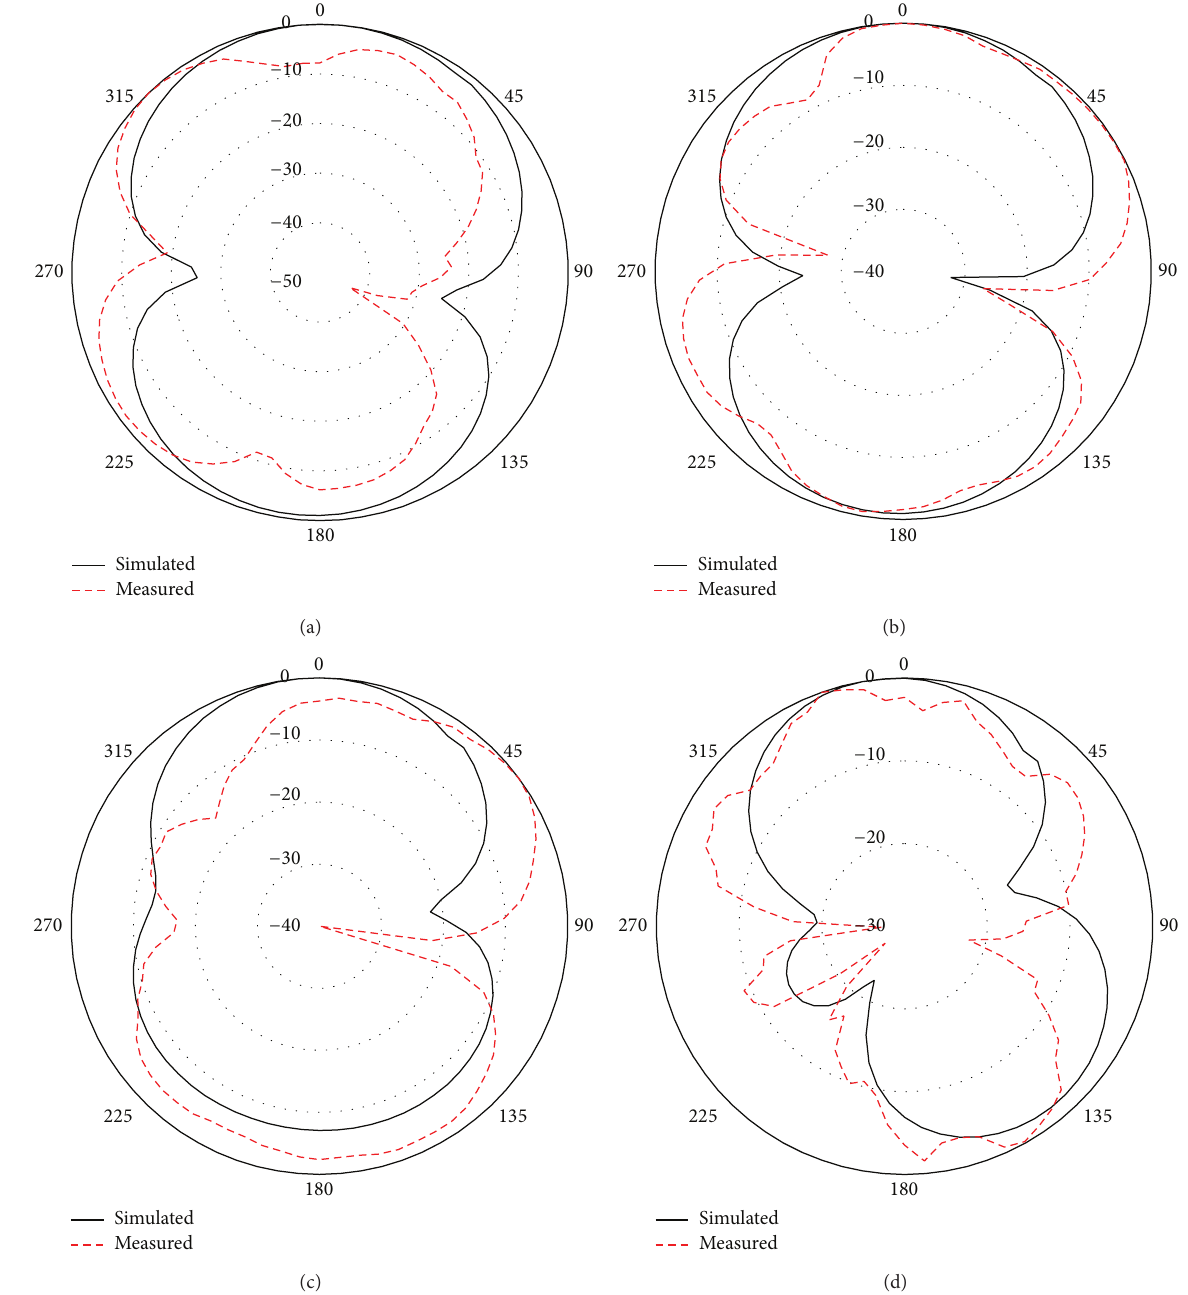
Figure 9: Simulated and measured radiation patterns at 𝑦𝑧 -plane at (a) 4.9 GHz, (b) 5.6 GHz, (c) 8.3 GHz, and (d) 10.6GHz.